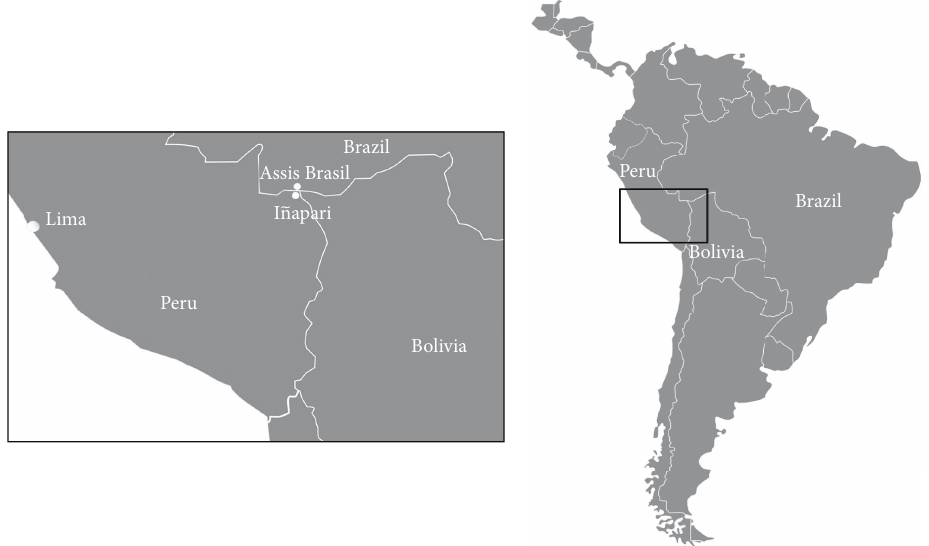
Figure 1: Map of I˜napari,